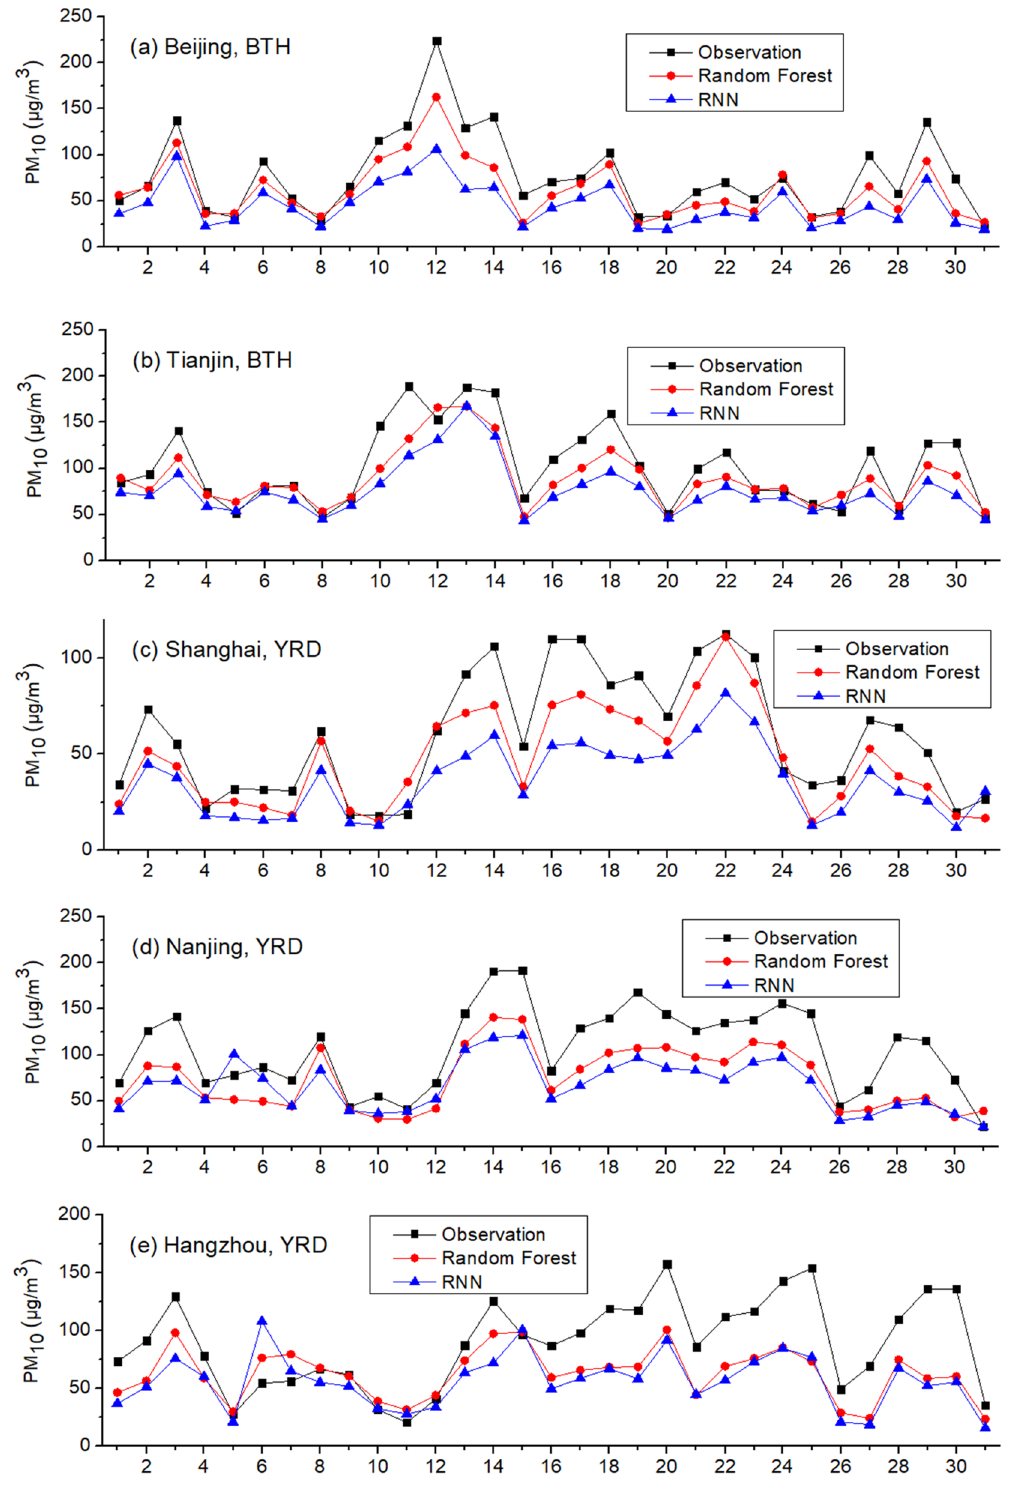
Figure 2. Observed and simulated PM 10 in January 2019: Scenario